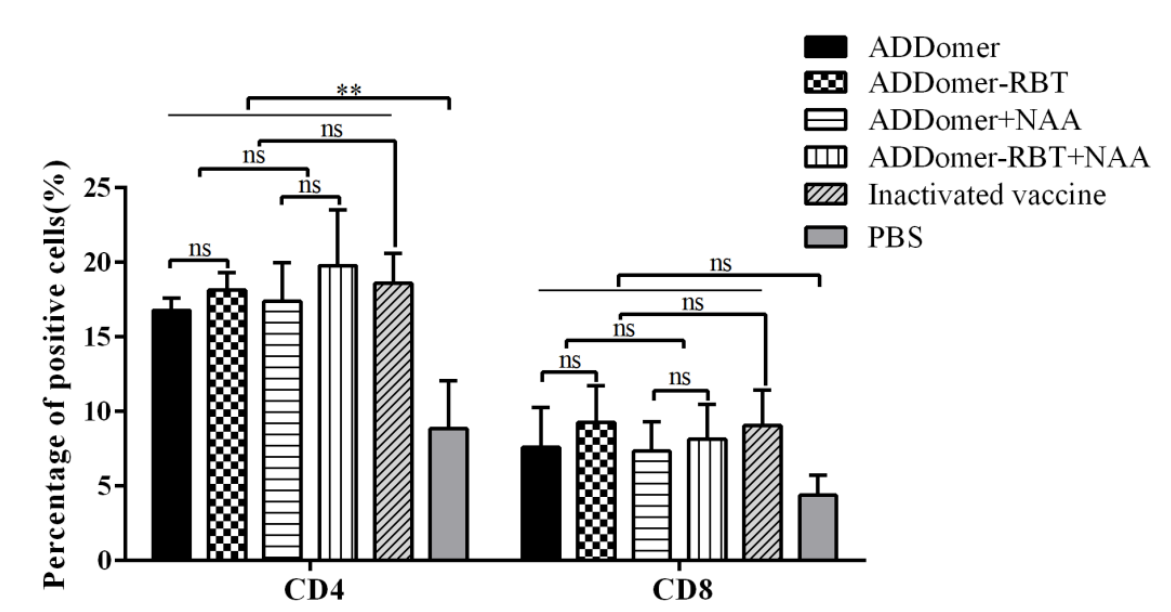
Figure 5. Expression levels of CD4 and CD8 cells were detected by flow cytometry 28 days after the first immunization in mice. Data represent the mean ± SEM. ** represents p < 0.01; ns represents no significant difference compared with PBS group ( p > 0.05).